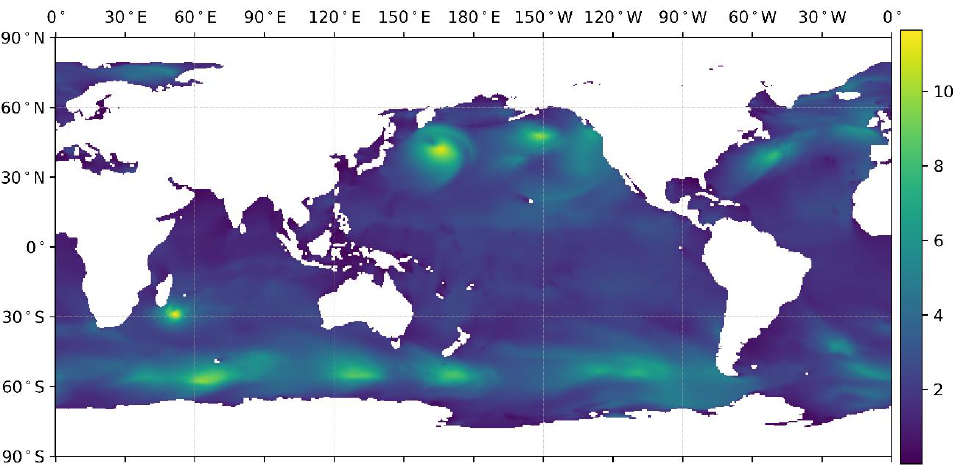
Appl. Sci. 2020 , 10 , x FOR PEER REVIEW Figure 7. Total wave height map on 20 January 2018 (m). Figure 7. Total wave height map on 20 January 2018 (m).